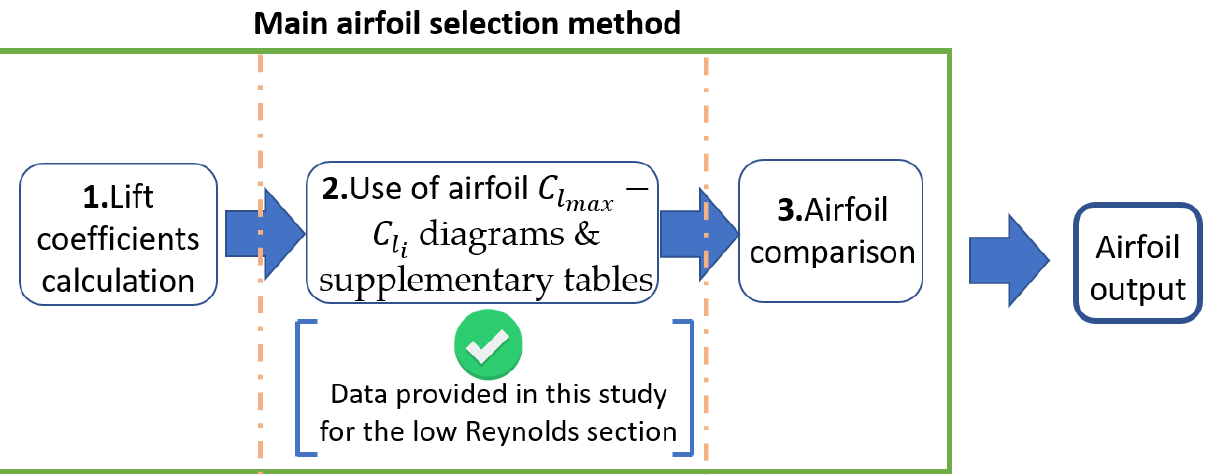
Figure 3. The internal procedures of the author Sadraey’s main airfoil selection procedure, divided in three main groups.